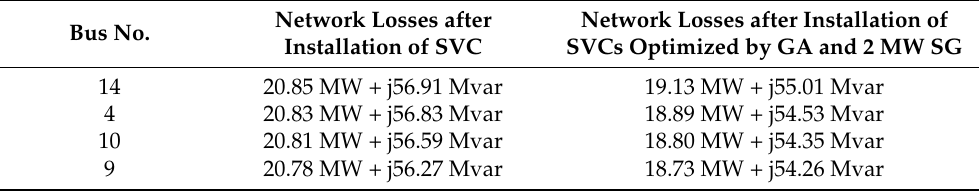
Table 10. The difference in network losses for IEEE 14-Test-Bus Systems with 2 MW solar generation. Total network losses after installation of SVC for j = 2 in four buses (candidate buses) Total network losses after installation of SVC optimized by GA 75.55